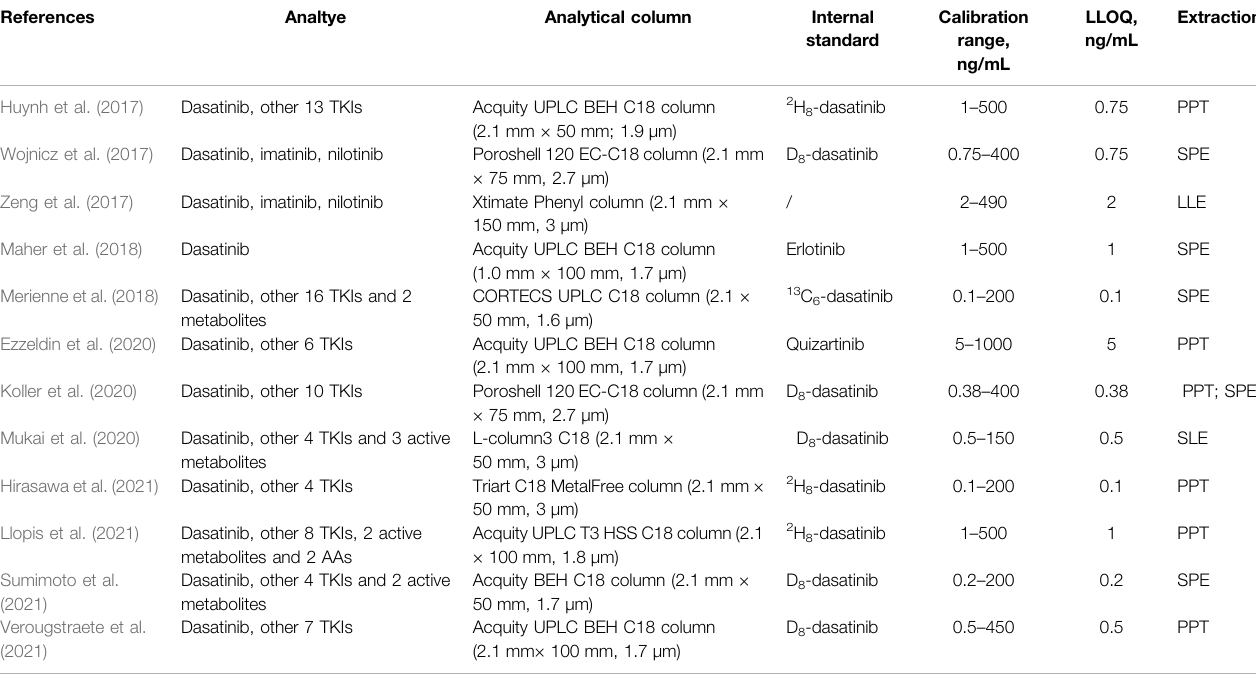
TABLE 3 | Overview of LC – MS/MS analytical methods of dasatinib in human plasma in recent 5